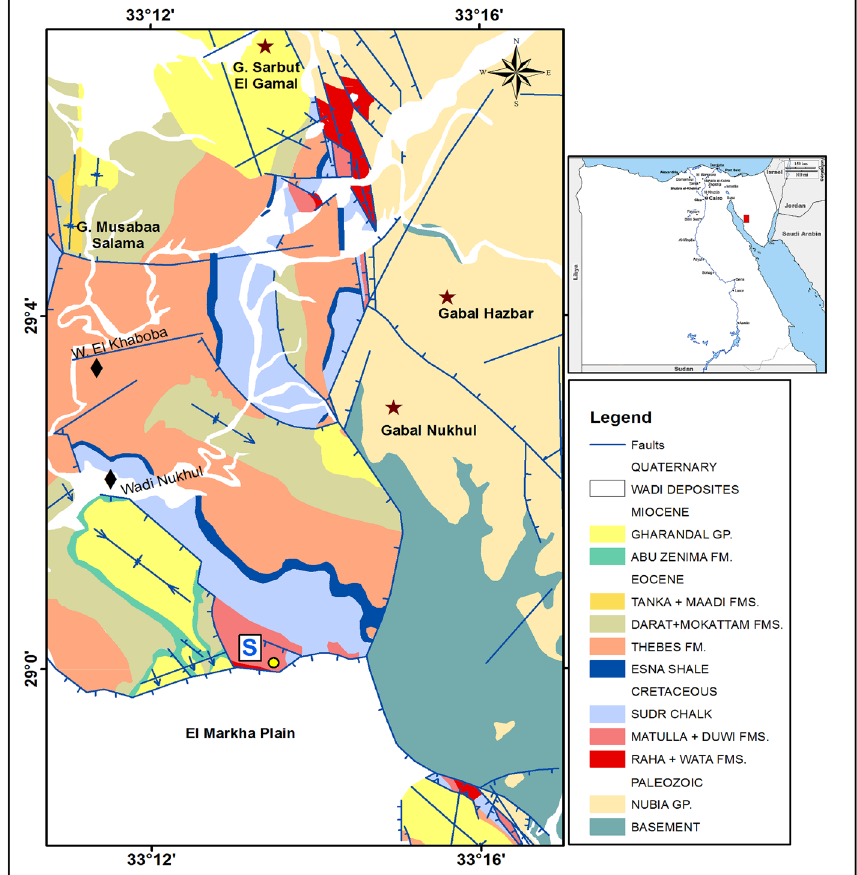
Figure 1. Geological map of the study area occurred along the Eastern side of the Gulf of Suez (modified after Moustafa (1993) 22 (permission number # 5437641072307) by using CorelDraw X3 on enhanced Sentinel-2A l3har risge ospat ial. com/ Softw are- Techn ology/ ENVI).